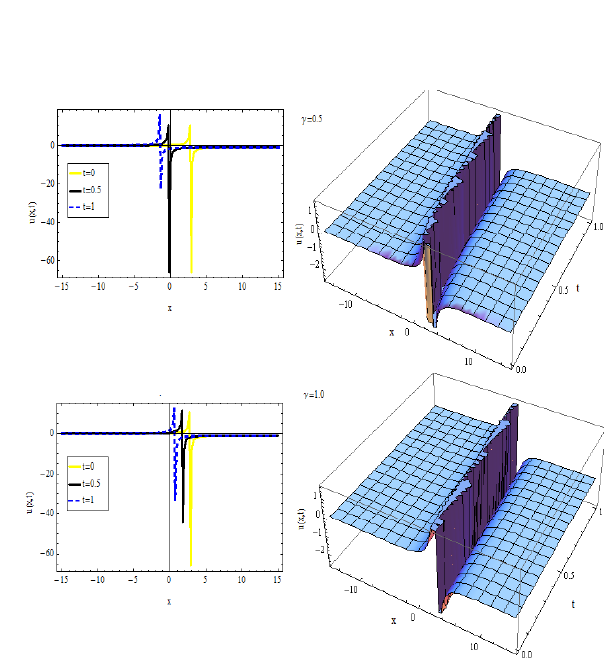
Figure 5: Graphs of (33) for conformable time-fractional Cahn-Allen